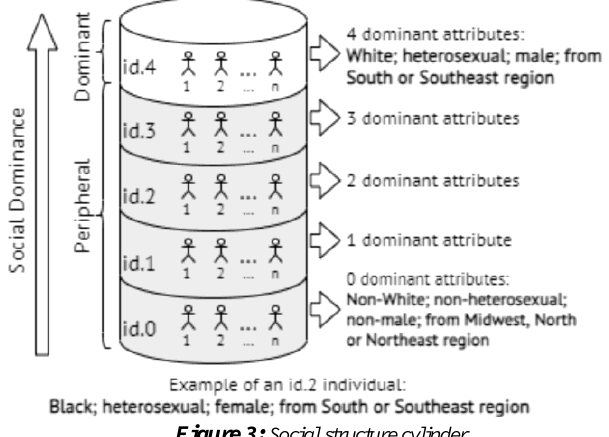
Figure 3: Social structure